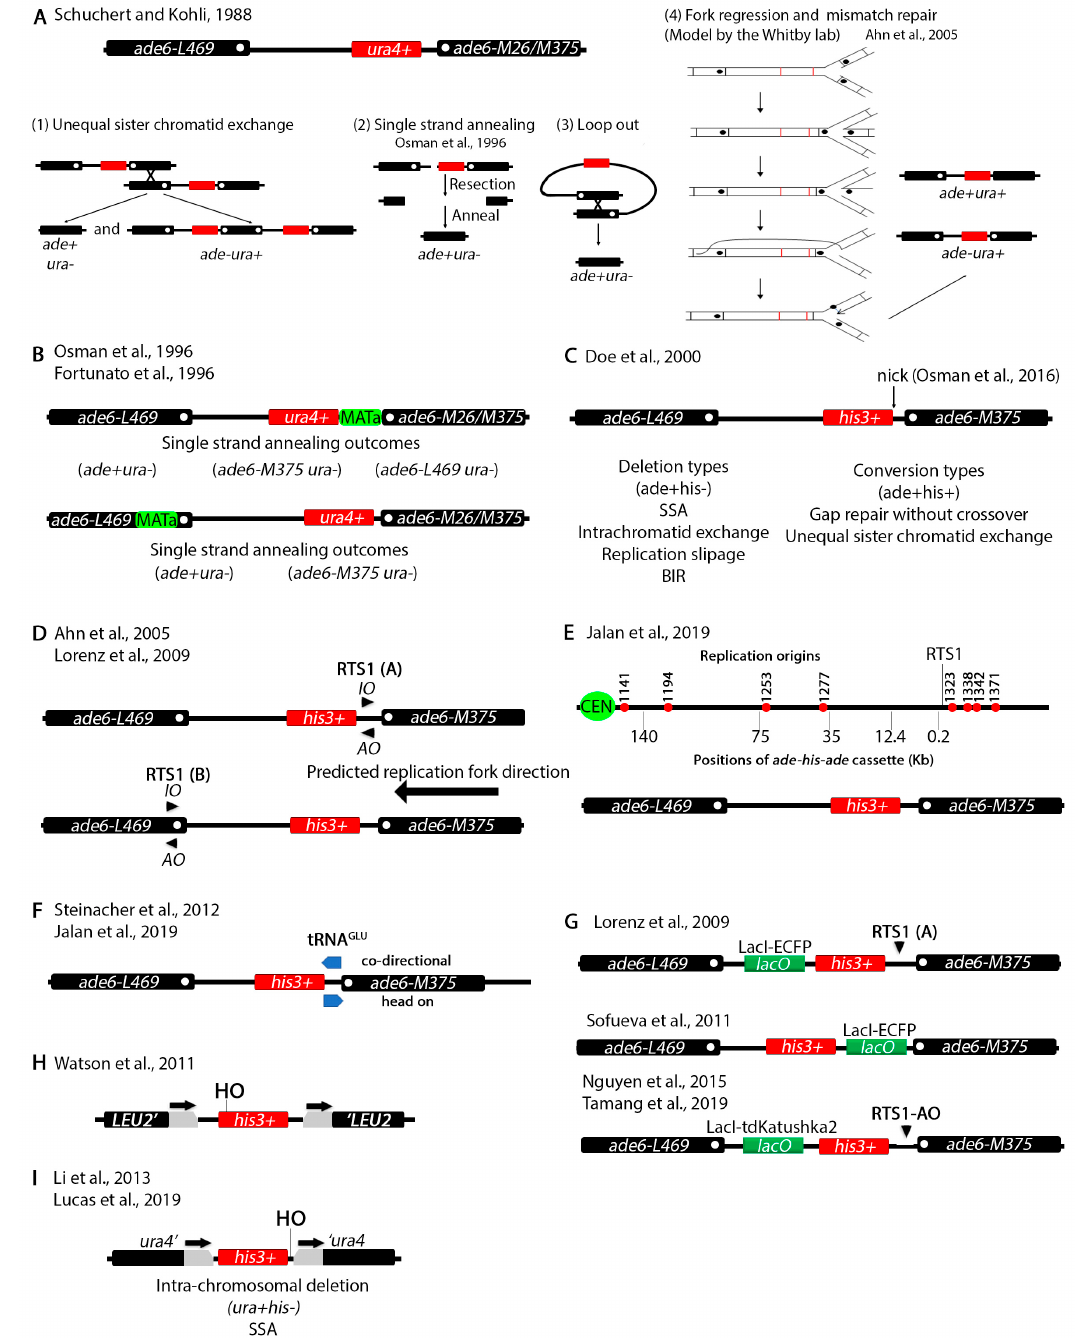
Figure 3. Recombination at tandem repeats. ( A ) An assay to study recombination at non-tandem direct repeats. The ade6-L469 and ade6-M26 or ade6-M375 inactivating alleles were placed on either side of a functional ura4 + gene. White dots represent the positions of the mutations in the ade6 alleles. The strain is adenine auxotrophic and uracil prototrophic (ade-ura + ). Di ff erent repair pathways lead to various phenotypic outcomes. Unequal sister chromatid exchange (1) produces both ade + ura- and ade-ura